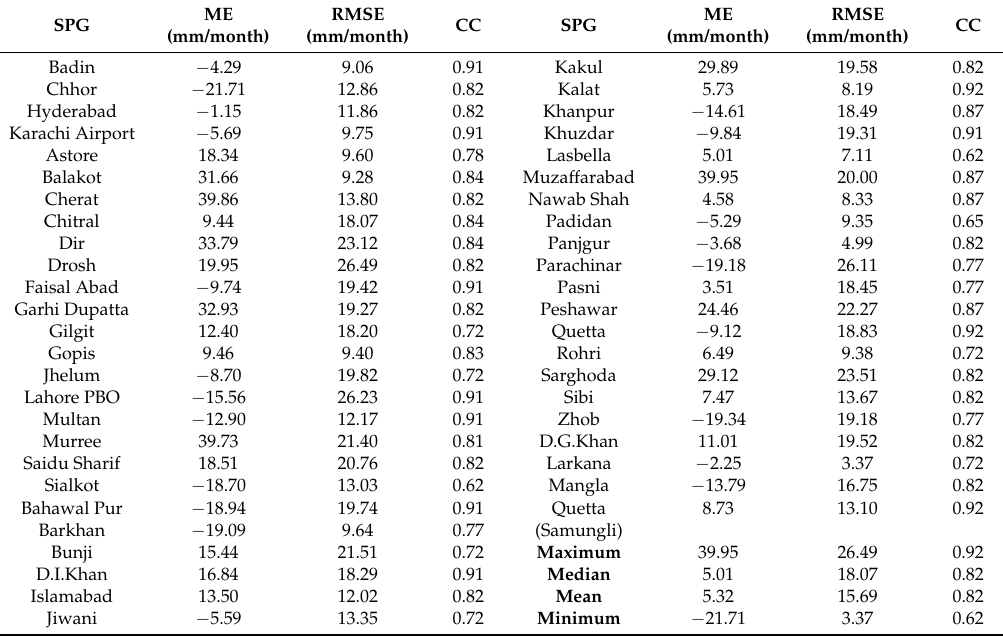
Table 6. Statistical evaluation of ensemble precipitation (EP) algorithm at selected